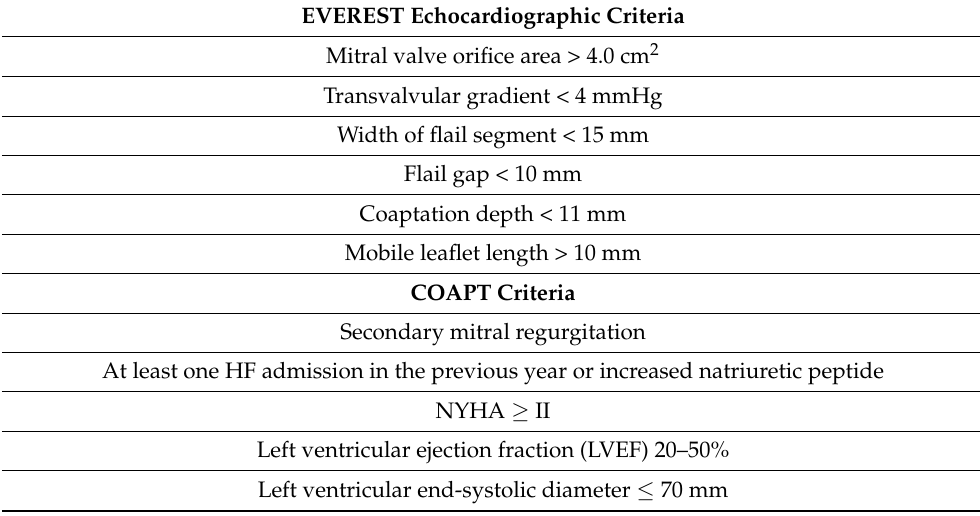
Table 3. EVEREST II and COAPT clinical and echocardiography criteria for MitraClip™